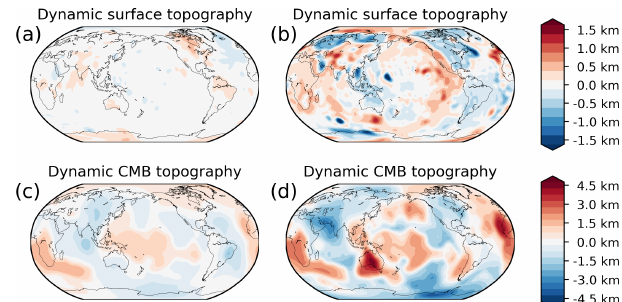
Figure 11. Dynamic contributions to boundary deformations from inverted density model and a two-layer viscosity model. The results are filtered to spherical harmonic degree 30. (a) Contribution of up- per 300km to surface topography for the inversion results based on the isostatic residual. (b) The same for the results based on the crustal residual. Note that some structures appear which were not seen in Fig. 10b. This is caused by strong density anomalies below 300km depth, which were not considered in the isostatic calculation shown in Fig. 10b. (c) Dynamic core–mantle boundary topography based on the isostatic residual inversion. Positive values indicate a depression of the CMB. (d) The same for the crustal residual inver-